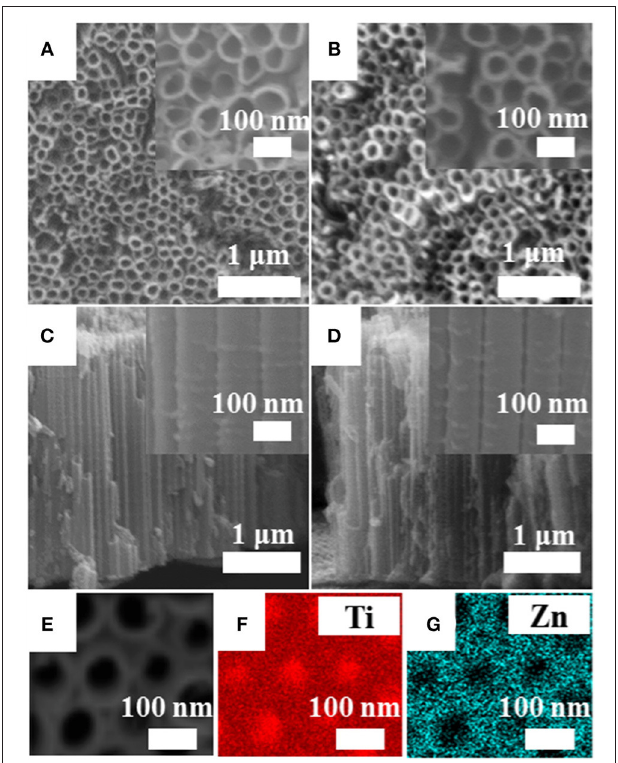
FIGURE 4 | Transmission electron microscopy (TEM) images of (A) pristine TiO 2 nanotubes and (B) TiO 2 @ZnO composites. (C) SAED pattern of TiO 2